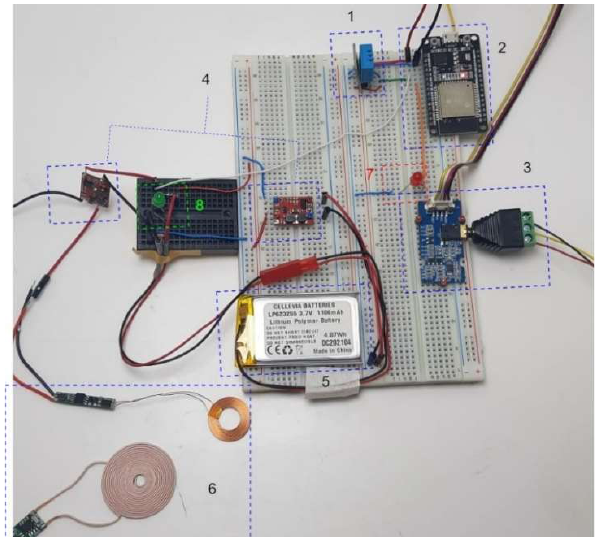
Figure 15. Final assembly of the circuit.